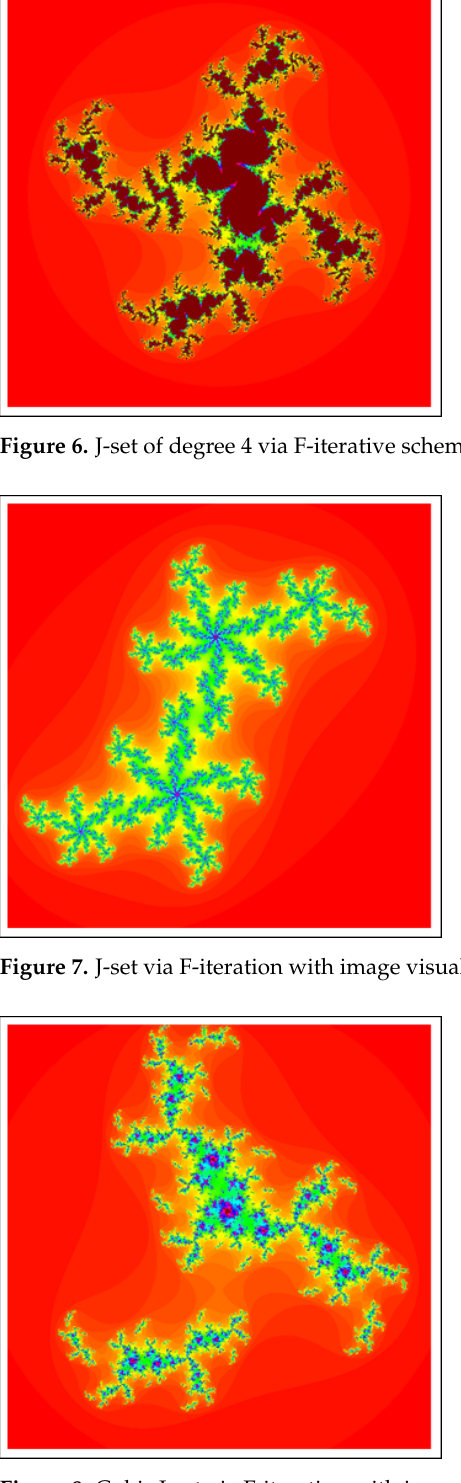
Figure 8. Cubic J-set via F-iteration with image visual time = 33.48